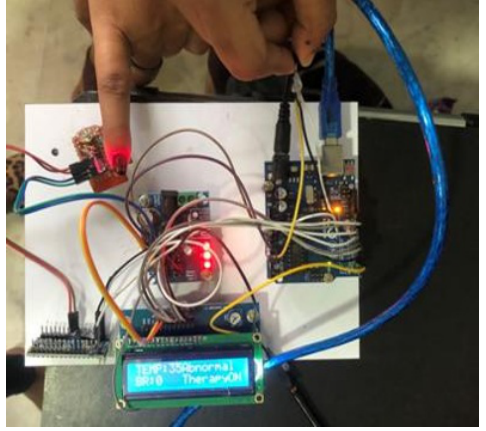
Along with this, the output box has other features or plots such as performance plot, training state plot and three other plots to analyse the system. The readings of the vital parameters along with the condition whether normal or abnormal is displayed on a LCD screen. After the program is run, different plots such as performance, training state, confusion, error histogram were